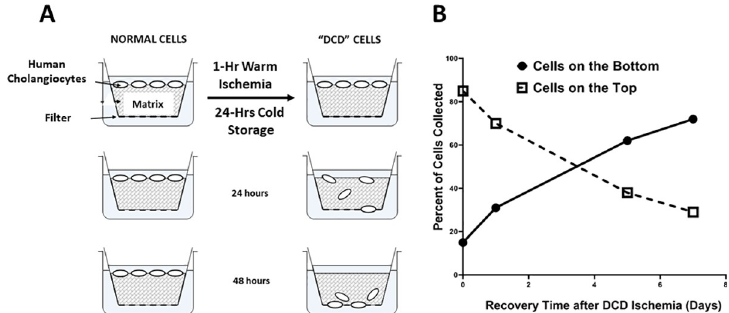
Fig 1. Cholangiocyte migration assay. Cholangiocyte migration was measured in an invasion chamber using a collagen gel matrix to detect cells with invasive and migratory behavior after exposure to DCD conditions (panel A). Cholangiocytes migrated through the matrix at increased rates depending on how long they were allowed to recover after exposure to DCD conditions. Specifically, a progressively larger percentage of cells reached the bottom of the chamber after 48 hours as the recovery time increased from 1–7 days (panel B). Results are expressed as mean +/- SD, n = 5.